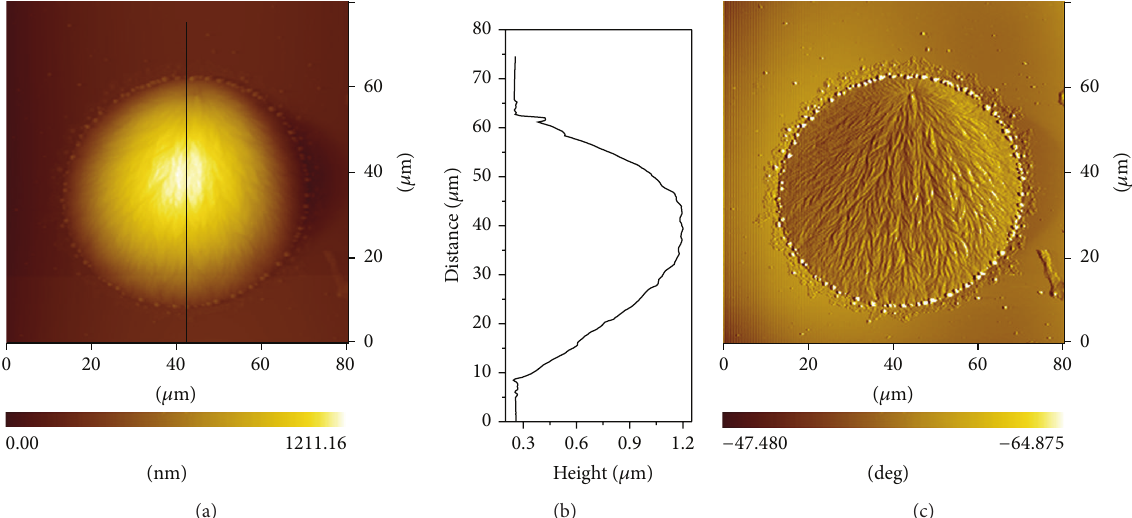
Figure 3: AFM topography (a) and phase image (c) of droplet in the film of initial thickness of 43.9 nm (b) is the corresponding cross-section line profiles in (a).